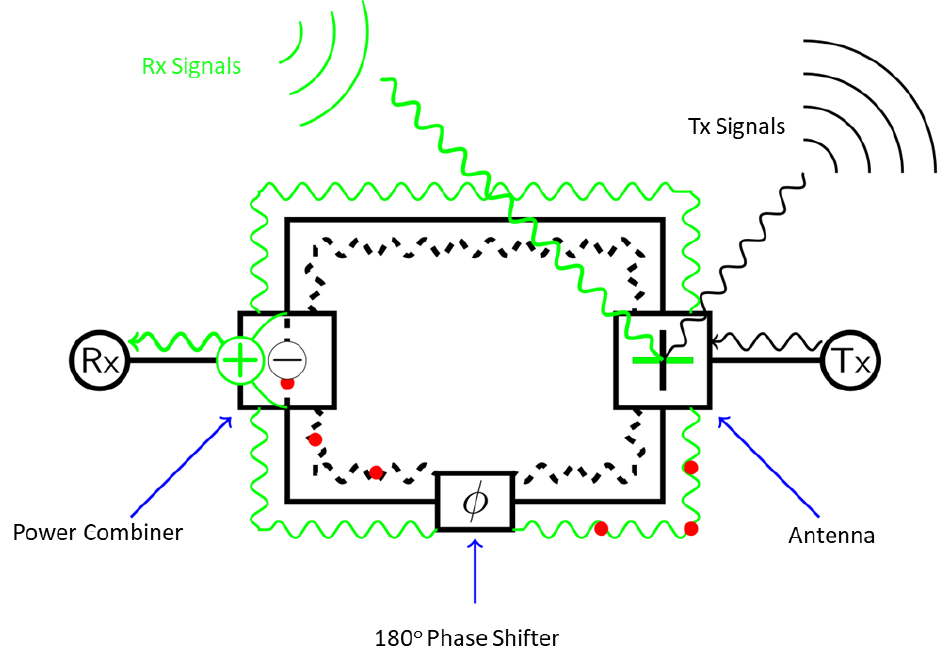
Figure 1. Proposed SIW antenna system operation [red dot represent the out of phase